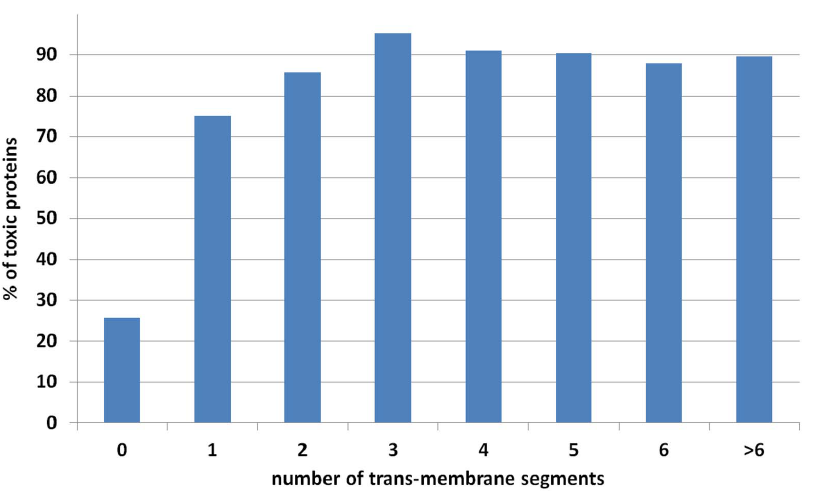
Figure 2. Percentage of toxic proteins as a function of number of trans-membrane segments. In proteins without any trans-membrane segment, about 25% are toxic. This percentage increases to , 73% in proteins with one trans-membrane segment and , 85% in proteins with two or more trans-membrane segments. Number of trans-membrane segments were predicted using TMHMM [35].